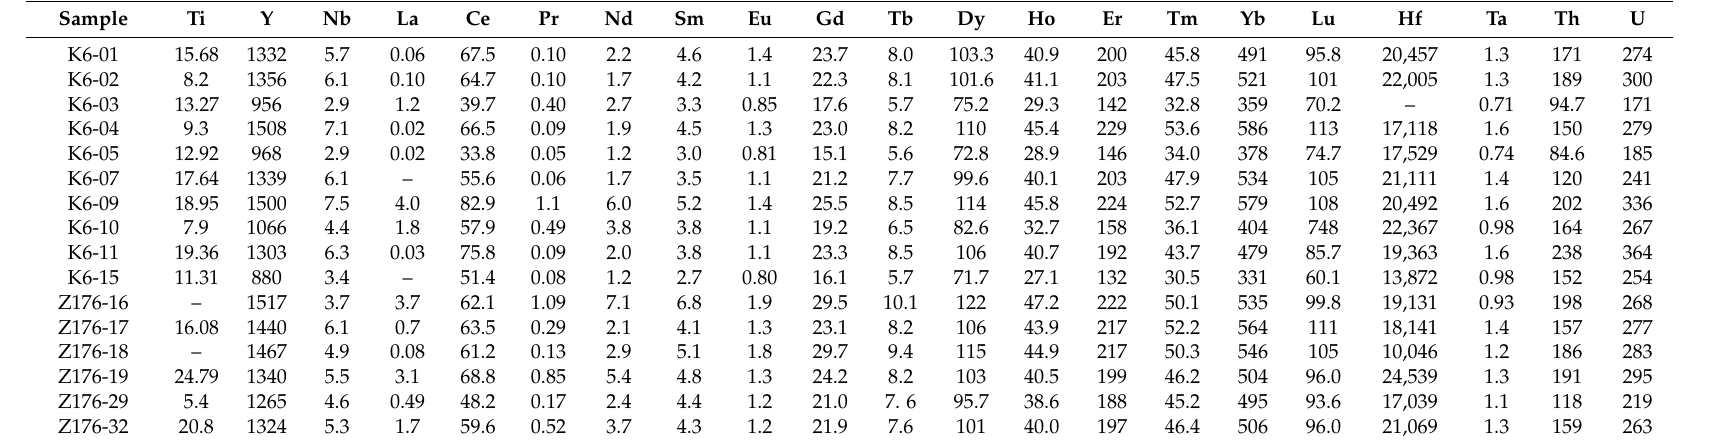
Table 5. The content of trace elements for zircon from Xiajinbao granite